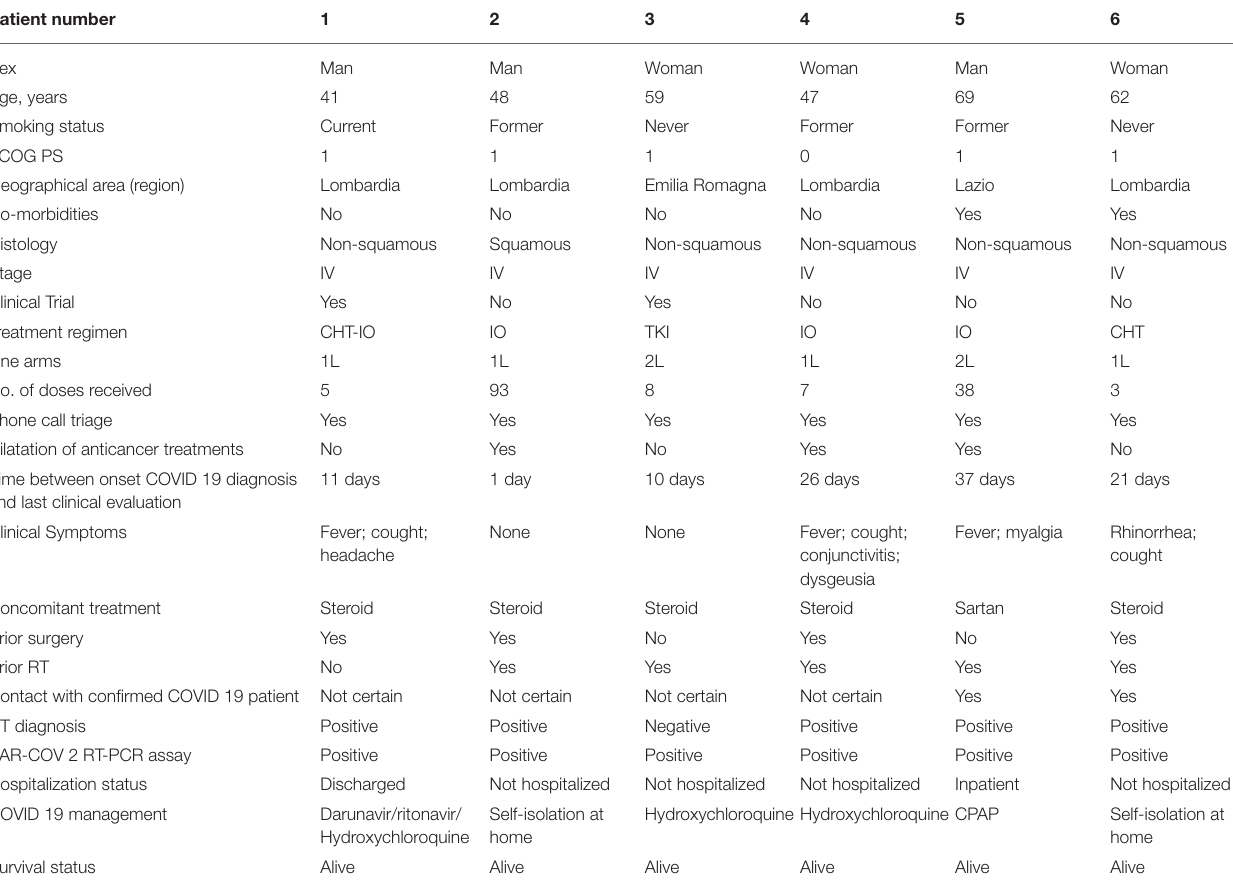
TABLE 2 | Demographic and clinical characteristics of NSCLC COVID 19 patients. Patient